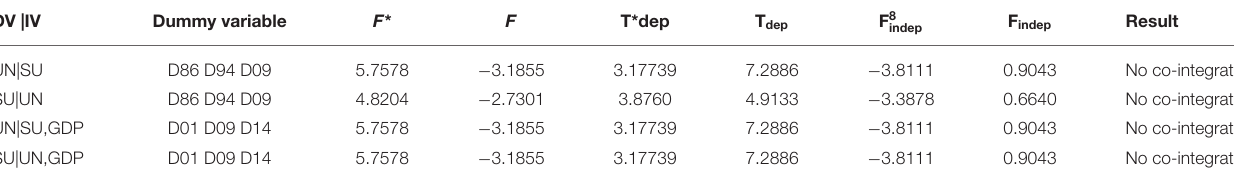
TABLE 2 | Co-integration analysis.